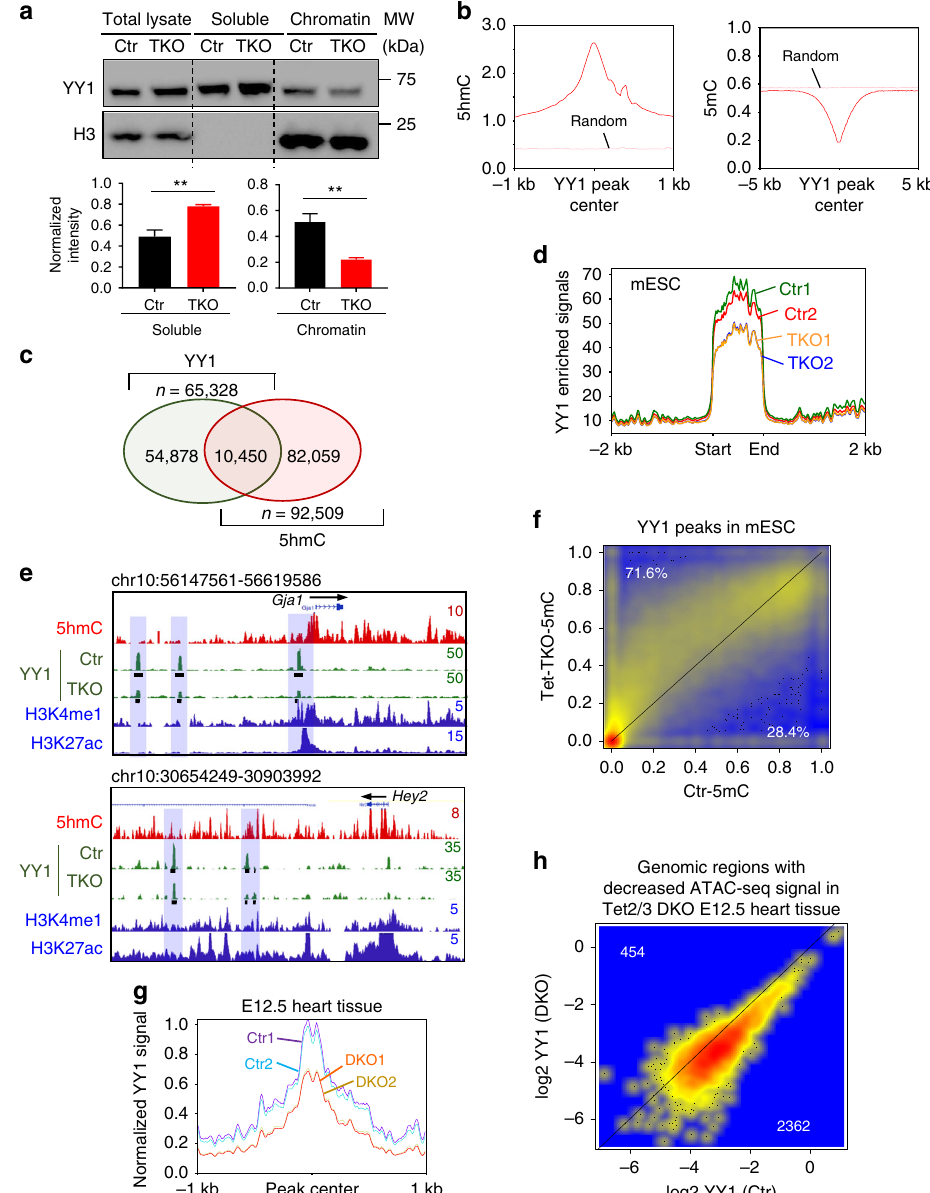
Fig. 6 Tet2/3 deletion compromised the binding of YY1 to chromatin. a (Top) Representative western-blot analysis of YY1 binding to chromatin in WT and Tet-TKO mESCs. (Bottom) Quanti fi cation of the intensity of YY1 soluble and chromatin associated fractions in WT and Tet-TKO mESCs. Data were shown as mean ± S.D; n = 3 independent experiments. ** p < 0.01 compared to WT (two-tailed Student ’ s t -test were used). b Enrichment of 5hmC (left) and 5mC (right) signals within YY1-enriched peaks. Random regions were used as control. c Venn diagram showing overlapped peaks between YY1- and 5hmC- enriched regions in mESCs. 10,450 overlapping peaks were identi fi ed. d YY1 enrichment in WT (red and green) and Tet-TKO (yellow and blue) mESCs. e Exemplary genome-browser views of 5hmC enrichment in WT mESCs (red trace) and YY1 enrichment (green) at the Gja1 and Hey2 loci in WT and Tet- TKO mESCs. Representative genomic regions that showed reduction in YY1 enrichment in Tet-TKO mESCs (compared to control) were highlighted in blue. The black bars beneath the peaks indicated the called peaks. f Scatterplot depicting the DNA methylation levels within the YY1 enriched regions in WT ( x -axis) and Tet-TKO ( y -axis) mESCs. g YY1 enrichment in control (blue and purple) and Tet-DKO (yellow and orange) mouse embryonic heart tissues collected at the E12.5 stage. h Scatterplot depicting YY1 enrichment within the genomic regions that showed decreased ATAC-seq signals in control ( x -axis) and Tet-DKO ( y -axis) heart tissues collected at E12.5 mouse